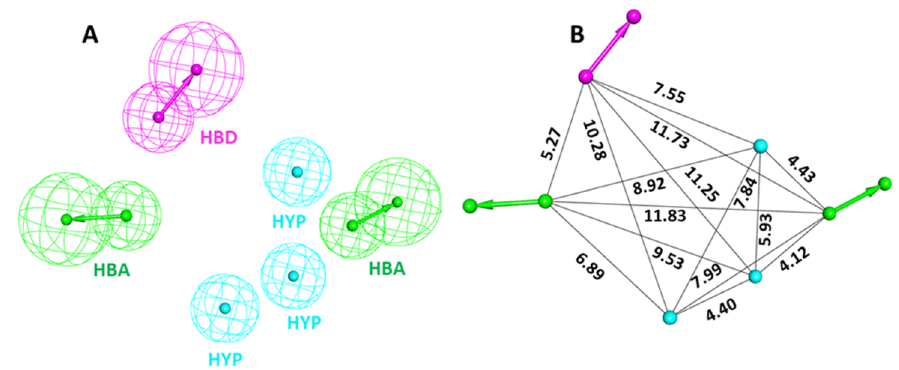
Figure 3. Chemical characterization of the selected Hypo 1. ( A ) Green, magenta, and cyan colors represent hydrogen bond acceptor (HBA), hydrogen bond donor (HBD), and hydrophobic (HYP) features, respectively. ( B ) The inter-feature distance of Hypo 1 displayed in Å.